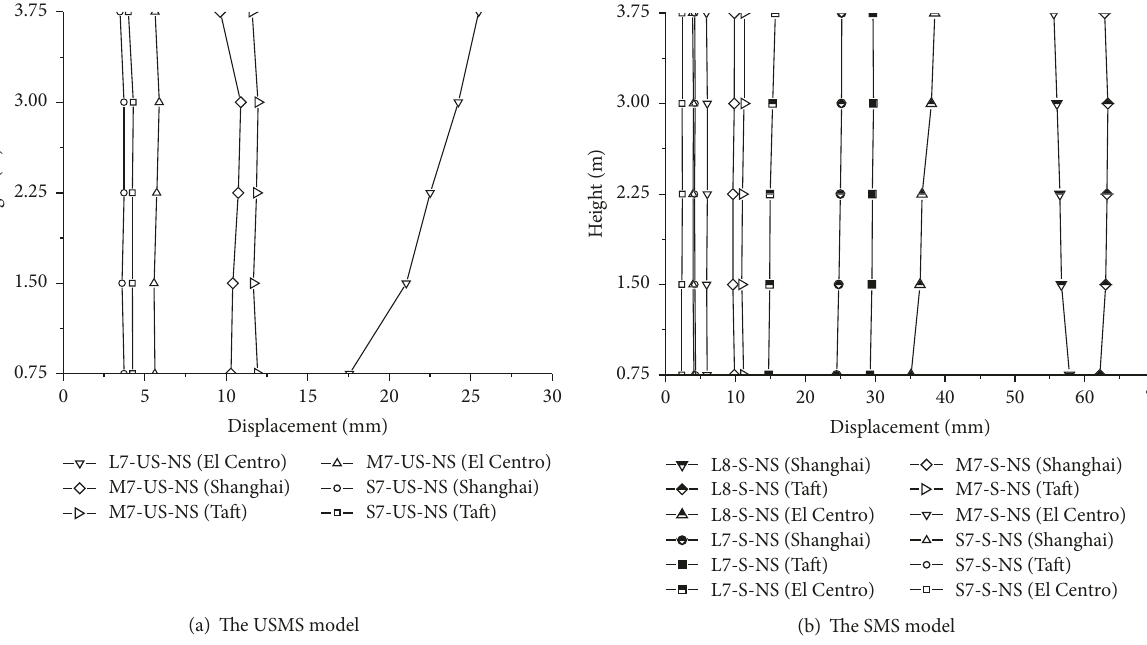
Figure 9: Envelopes of maximum displacements of USMS model and SMS